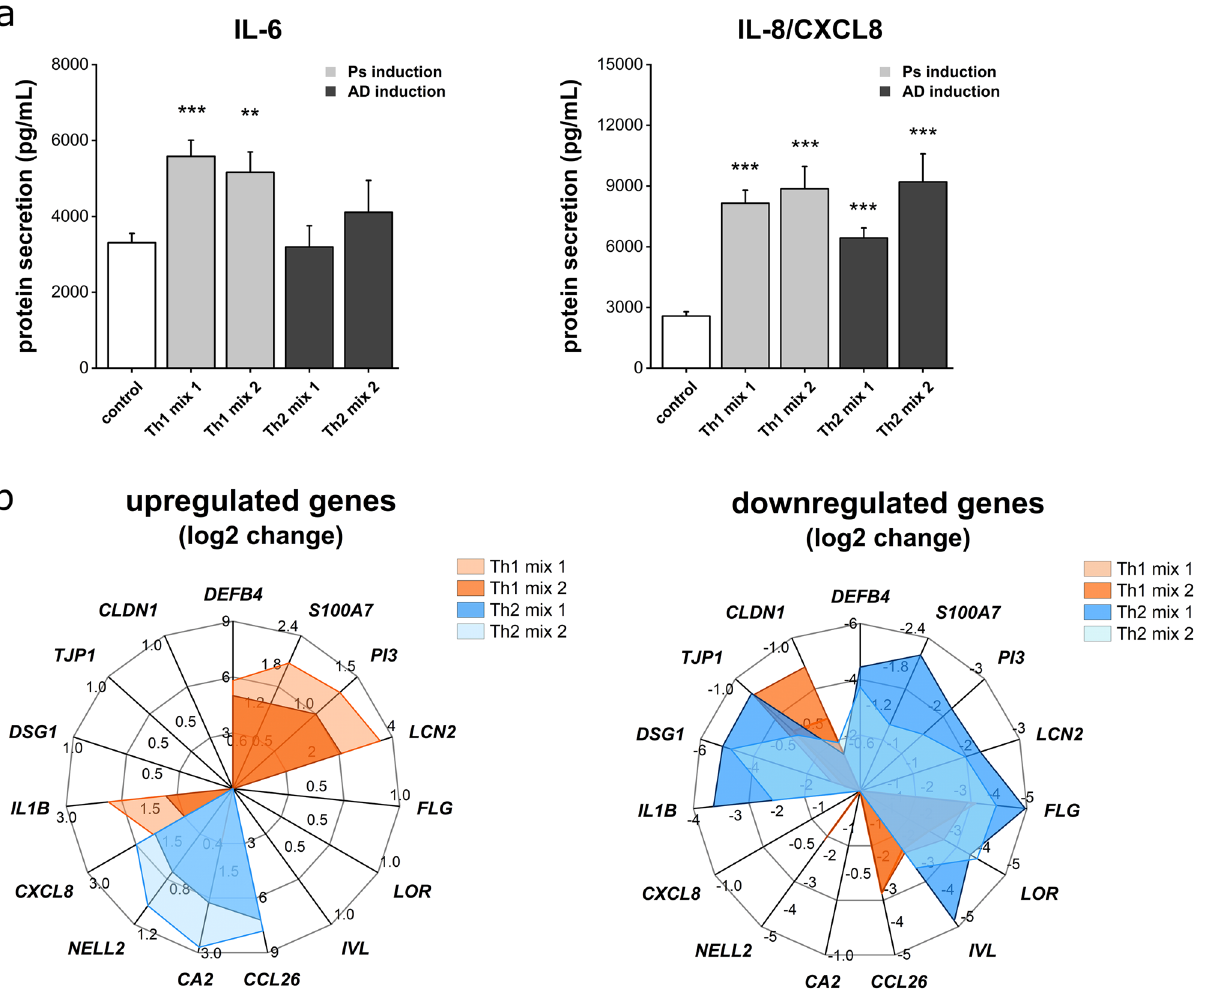
Figure 3. Release of pro-inflammatory mediators and disease-associated gene expression patterns. ( a ) Secretion of the cytokines IL-6 and IL-8/CXCL8 in undernatants of skin equivalents stimulated with Th1 or Th2 cytokine mixes compared to an unstimulated physiological control was measured by ELISA. Values are mean + SEM of n = 2 experiments with a total of 8 skin models (keratinocytes derived from one donor). Statistics: Mann– Whitney U test; p ≤ 0.05 *, p ≤ 0.01 **, p ≤ 0.001 *** compared to control. ( b ) Log2 change of mRNA expression of genes encoding antimicrobial peptides ( DEFB4 , S100A7 , PI3 , LCN2 ), structural proteins ( FLG , IVL , LOR ), chemokines & cytokines ( CXCL8 , IL1B , CCL26 ), AD biomarkers ( CA2 , NELL2 ) and protein components of cellular adhesions ( DSG1 , TJP1 , CLDN1 ) was determined by real-time qPCR. Values are mean of n = 2 experiments with a total of 4 skin mRNA levels of the chemokine CXCL8 and the cytokine IL1B were monitored. CXCL8 expression was signifi- cantly elevated in both, Ps- and AD-associated skin equivalents. Upon Th1 stimulation, IL1B transcription was increased. In contrast, the cytokine gene appeared to be downregulated in AD skin models (Fig. 3b, Supplemen- tary Fig. S1). Another target group aimed at genes encoding proteins involved in the formation of cell–cell adhe- sions. The mRNA expression of the desmosomal gene DGS1 was depleted in the both diseased models, with AD models being more negatively affected on transcriptional level than the Ps ones. In addition, the tight junction gene TJP1 was downregulated under Th1 and Th2 environments as well. On the contrary, CLDN1 transcripts appeared to be decreased in Ps skin models but were only marginally lower in AD substitutes. Hyperproliferation in Ps‑like skin models. Mitotic events in the stratum basale were visualized by IHC staining of the proliferation marker Ki67. Mitosis occurred in each skin equivalent restricted to the basal layer. Ps models were shown to feature a distinctly higher number of Ki67-positive basal cells (Fig. 4a). Cell divisions were quantified by counting the number of Ki67-positive cells per skin equivalent. Stimulation with Th1 cock- tails resulted in significantly increased mitotic events in the stratum basale of Ps models compared to unstimu- lated controls or Th2-mediated AD substitutes. Addition of TNF-α to the cytokine mix (Th1 mix 2) further facilitated the mitogenic potential of the stimulation cocktail used for Ps induction (Fig. 4b).